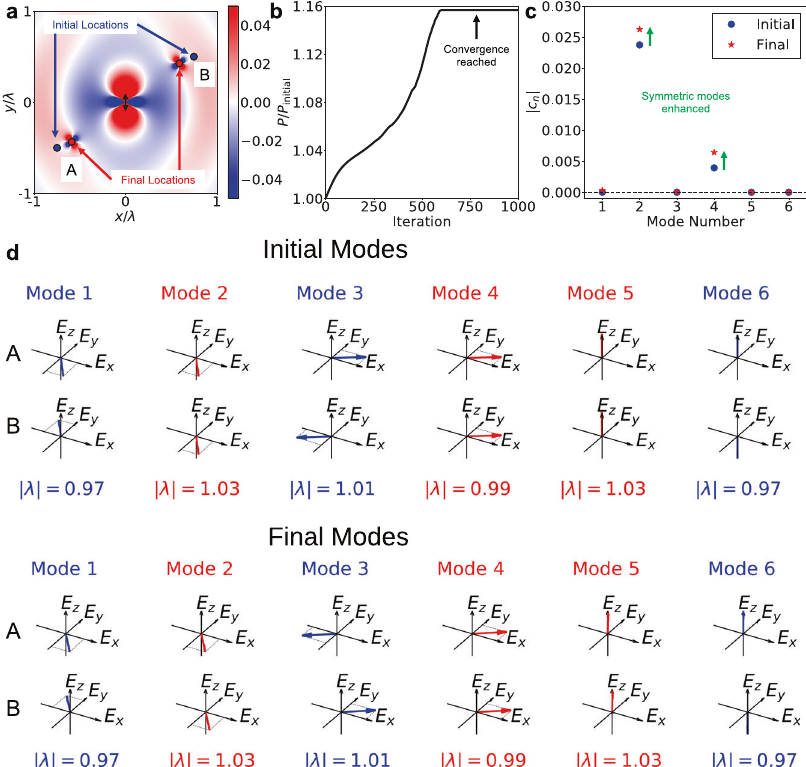
Fig. 2 A more detailed look at a simple example optimisation, to introduce the tools that will be used to characterise more complex structures. The aim is to enhance the power emission of the dipole emitter at the origin (black arrow). We consider two scatterers, labelled A and B, that support only an electric dipole ( α H = 0). ( a ) shows the con fi guration change during the optimisation. ( b ) shows the evolution of the power emission. ( c ) Shows how the optimisation process changes the relative dominance of the modes in the response of the system, as characterised by their expansion coef fi cient. ( d ) Shows how the eigenmodes of the system, with their associated eigenvalues, are modi fi ed by the design procedure. Note the two classes of mode: anti- symmetric (i.e. initial mode 1) shown in blue and symmetric (i.e. initial mode 2) shown in red. Eigenmodes are indicated as pairs of 3D vectors, representing